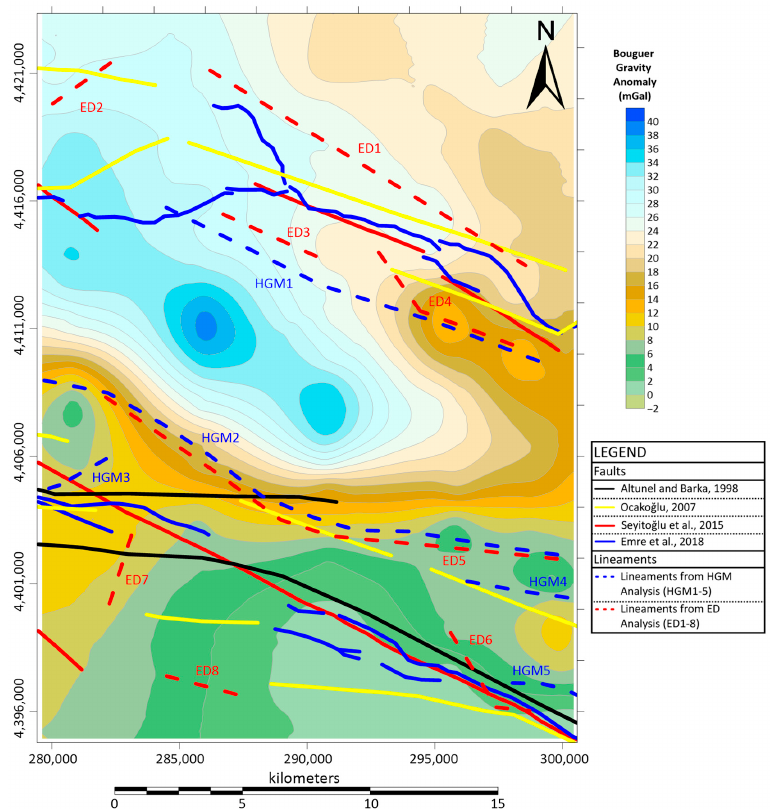
Figure 10. The ED and HGM lineaments on known faults in the study area (anomaly color scheme changed due to greater visibility) [4,10,11,27]. (Datum: WGS84 UTM Zone 36 N). Supplementary Materials: The following supporting information can be downloaded at: www.mdpi.com/xxx/s1, Data S1 [43] : 3 column tab-delimited ASCII file of the Bouguer gravity anomaly data of Eski ş ehir/Study Area: 1st column: Longitude, 2nd column: Latitude, 3rd column: Bouguer gravity anomaly. Scintrex CG-5 gravimeter has been used for data gathering. Javad Tri- umph-1 RTK (real time kinematics) device has been used for precise coordinate value and elevation value collecting. Geosoft Oasis Montaj application has been used for data processing. Author Contributions: Conceptualization, E.B.; methodology, E.B.; software, E.B and M.T.; valida- tion, E.B. and M.T.; formal analysis, E.B.; investigation, E.B. and M.T.; resources, E.B. and M.T.; data curation, E.B.; writing—original draft preparation, E.B.; writing—review and editing, E.B. and M.T.; visualization, E.B. and M.T.; supervision, M.T. All authors have read and agreed to the published version of the manuscript. Funding: This research received no external funding. Institutional Review Board Statement: The study did not require ethical approval. Informed Consent Statement: Not applicable. Data Availability Statement: Data is contained within the article or supplementary material. The data presented in this study are available in supplementary material.